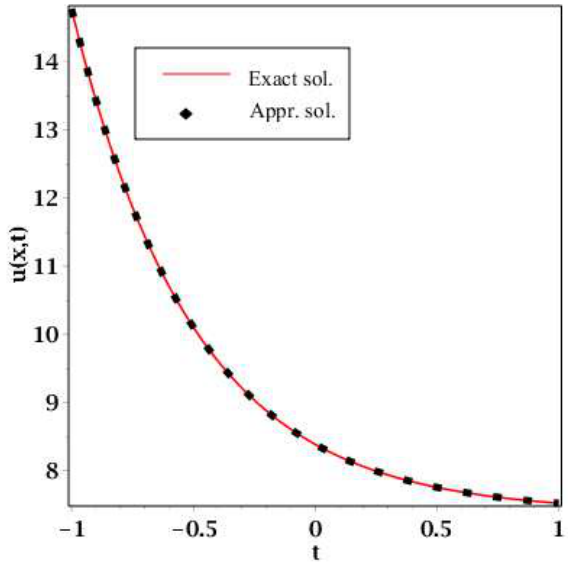
Fig. 2: Comparison between exact solution and approximate solu- tion for α =